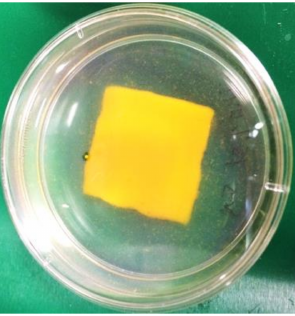
Figure A2. Macroscopic image of the CUR–CHI nanoplex-loaded HP starch film.